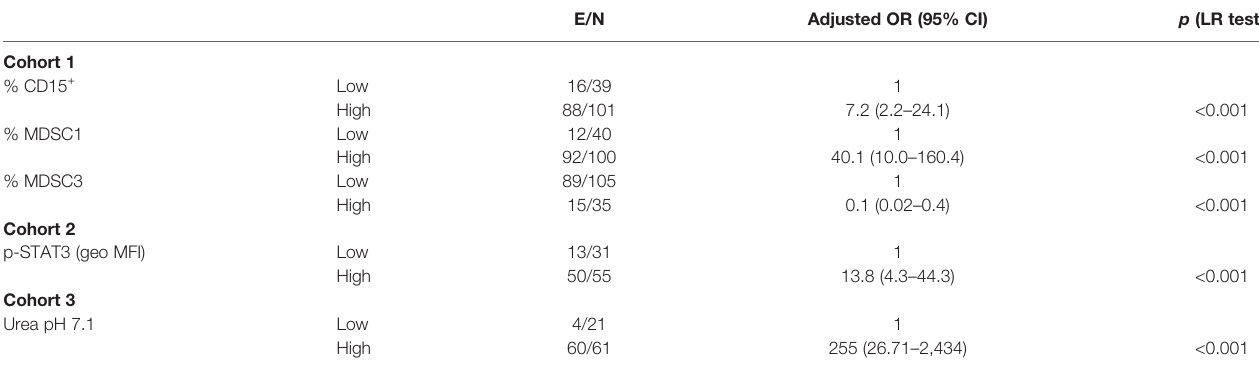
TABLE 2 | Factors for glioma risk (multiple analysis with logistic regression